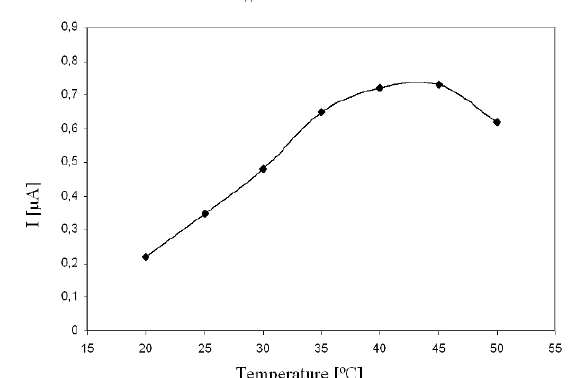
Figure 4. Effect of temperature on the amperometric response of ethanol biosensor in 0.3 mmol/L solution of ethanol in 0.1 M phosphate buffer solution (pH 8.0) containing = -50 mV vs. Ag/AgCl. 4 mmol/L b -NAD + ; E app.